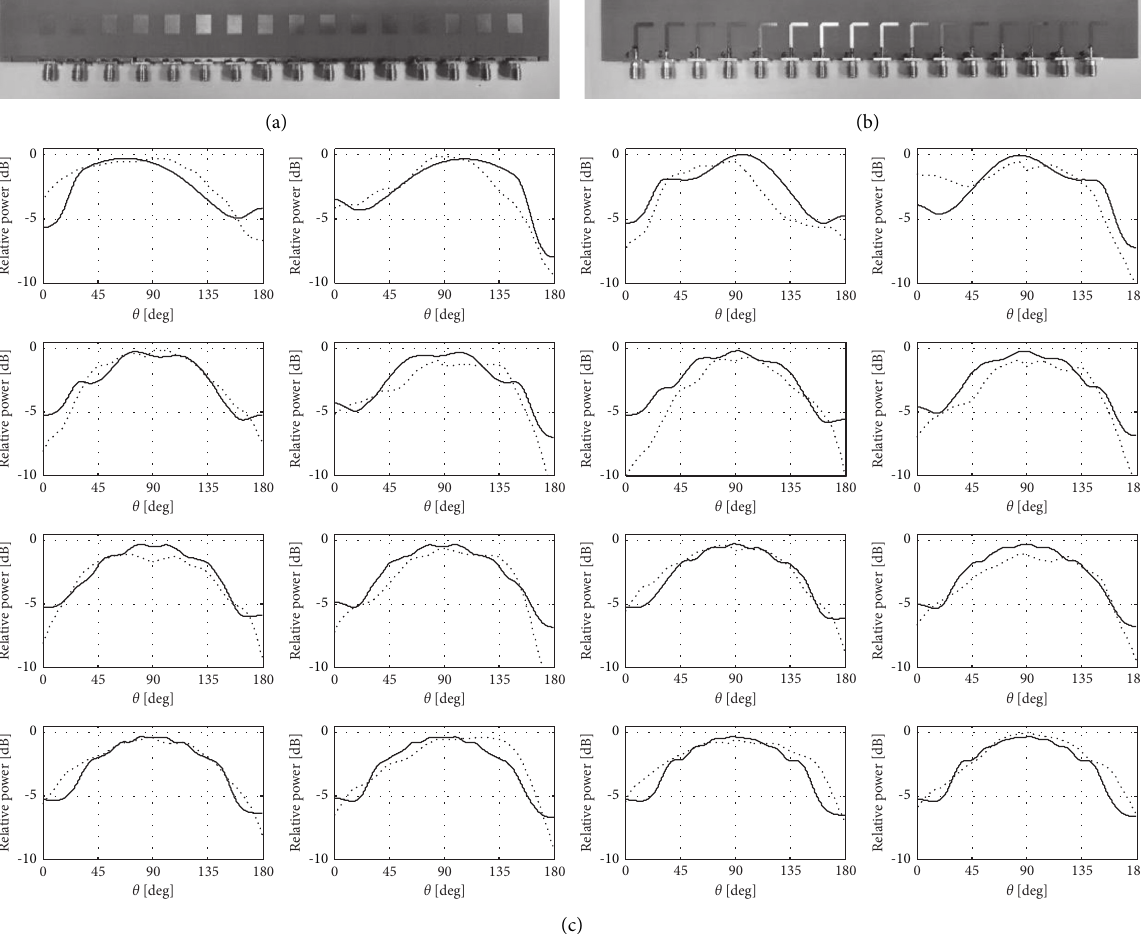
Figure 16: Antenna array operating at 10GHz [77]: (a) front view; (b) back view; (c) measured ( ... ) and simulated ( ▬ ) aperture-embedded- element E-plane patterns. The measured and simulated radiation patterns are normalized, respectively, to the maximal measured and simulated values. The patterns are displayed from top to bottom as follows: 1 and 16 (outermost elements), 2 and 15, ... , 7 and 8 (central